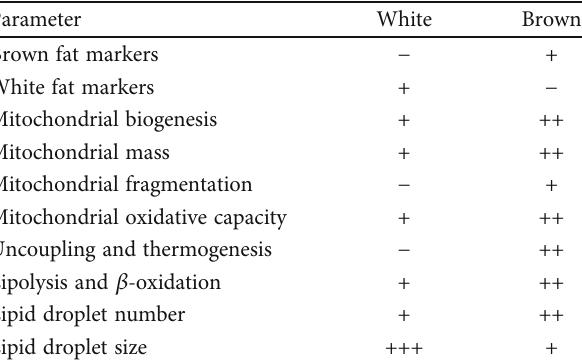
Table 2: White and brown adipocyte